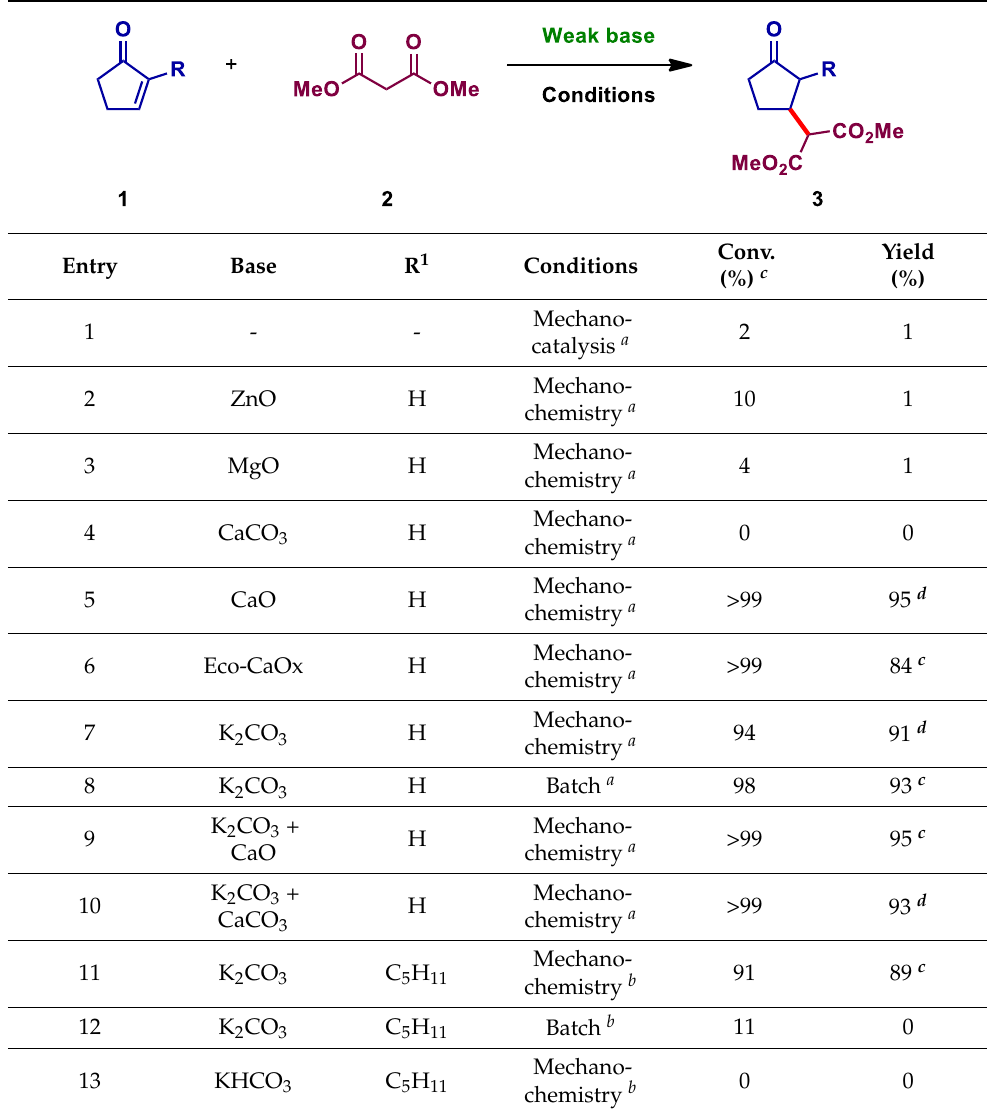
Table 1. Conditions optimization for mechanical Michael addition reaction.